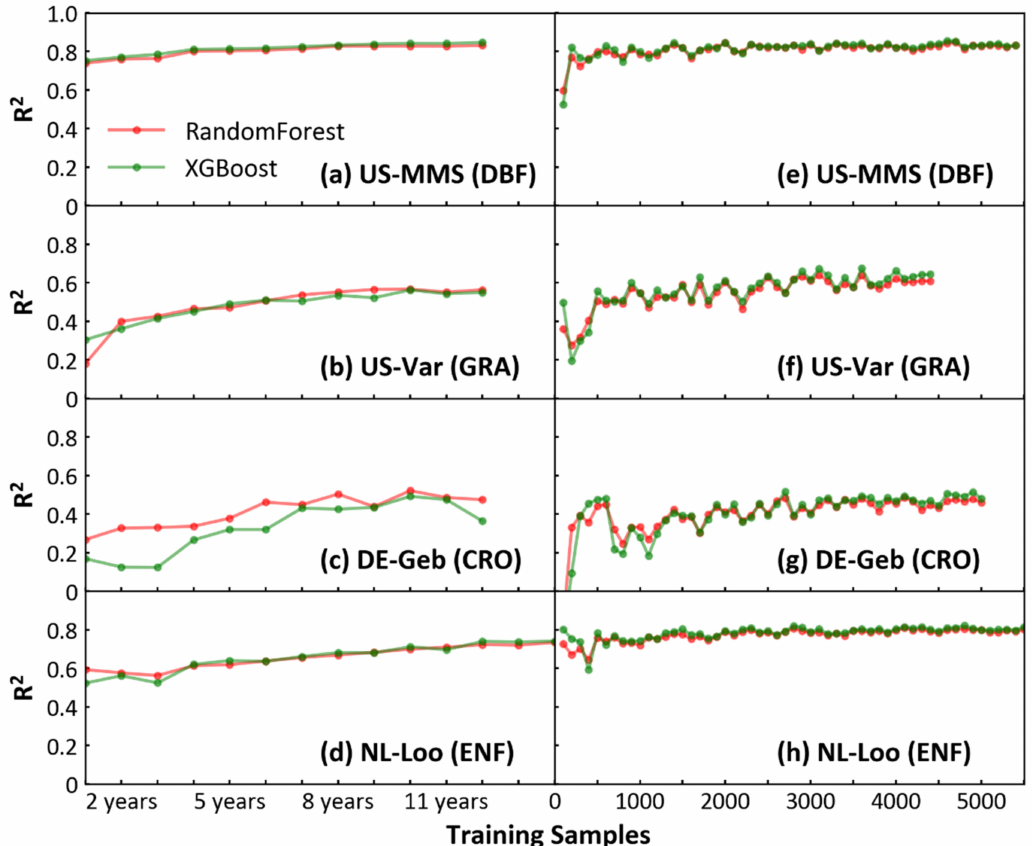
Figure 4. ( a – d ) Effect of increasing the training sample on the prediction results (take four sites as examples). Increasing training samples in terms of annual sample size (x axis) and the determination (R 2 ) from each test sample and predicted values (y axis). ( e – h ) Increase the total samples (70% of which are training samples and 30% are test samples) in steps of 100 (x axis), and the determination (R 2 ) as in ( a – d